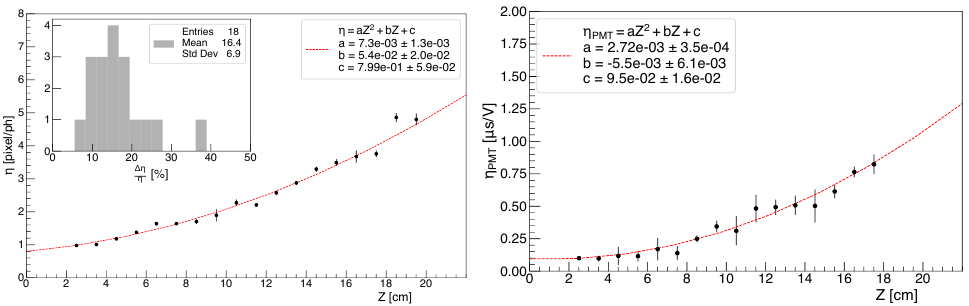
Figure 7. Dependence of η on the left and η PMT on the right as a function of the track distance from the GEM (see text for